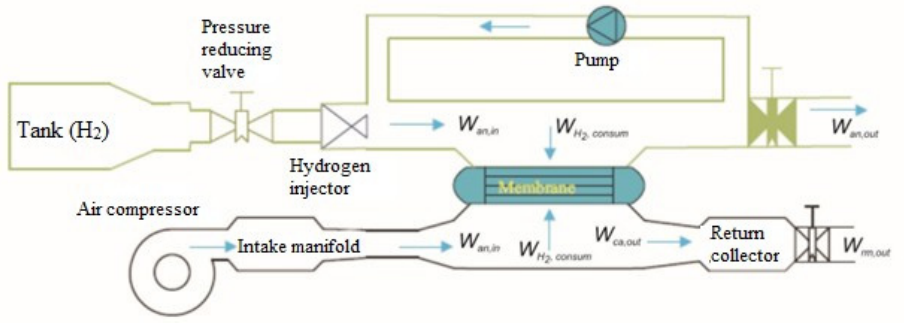
Figure 6. Functional model of an automotive hydrogen supply system with a PEM fuel cell [14].